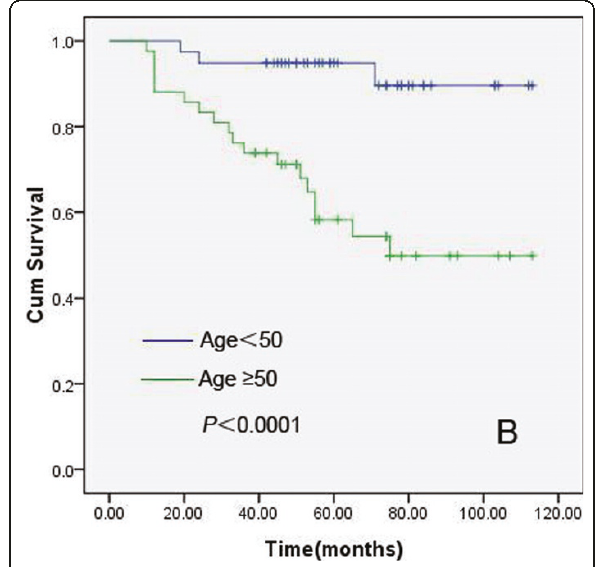
Figure 7 Kaplan-Meier comparison result showed that patient age ( ≥ 50 years) was correlated significantly with IDC patients ’ shortened overall survival . Log rank test P -value (two sided) was listed in the